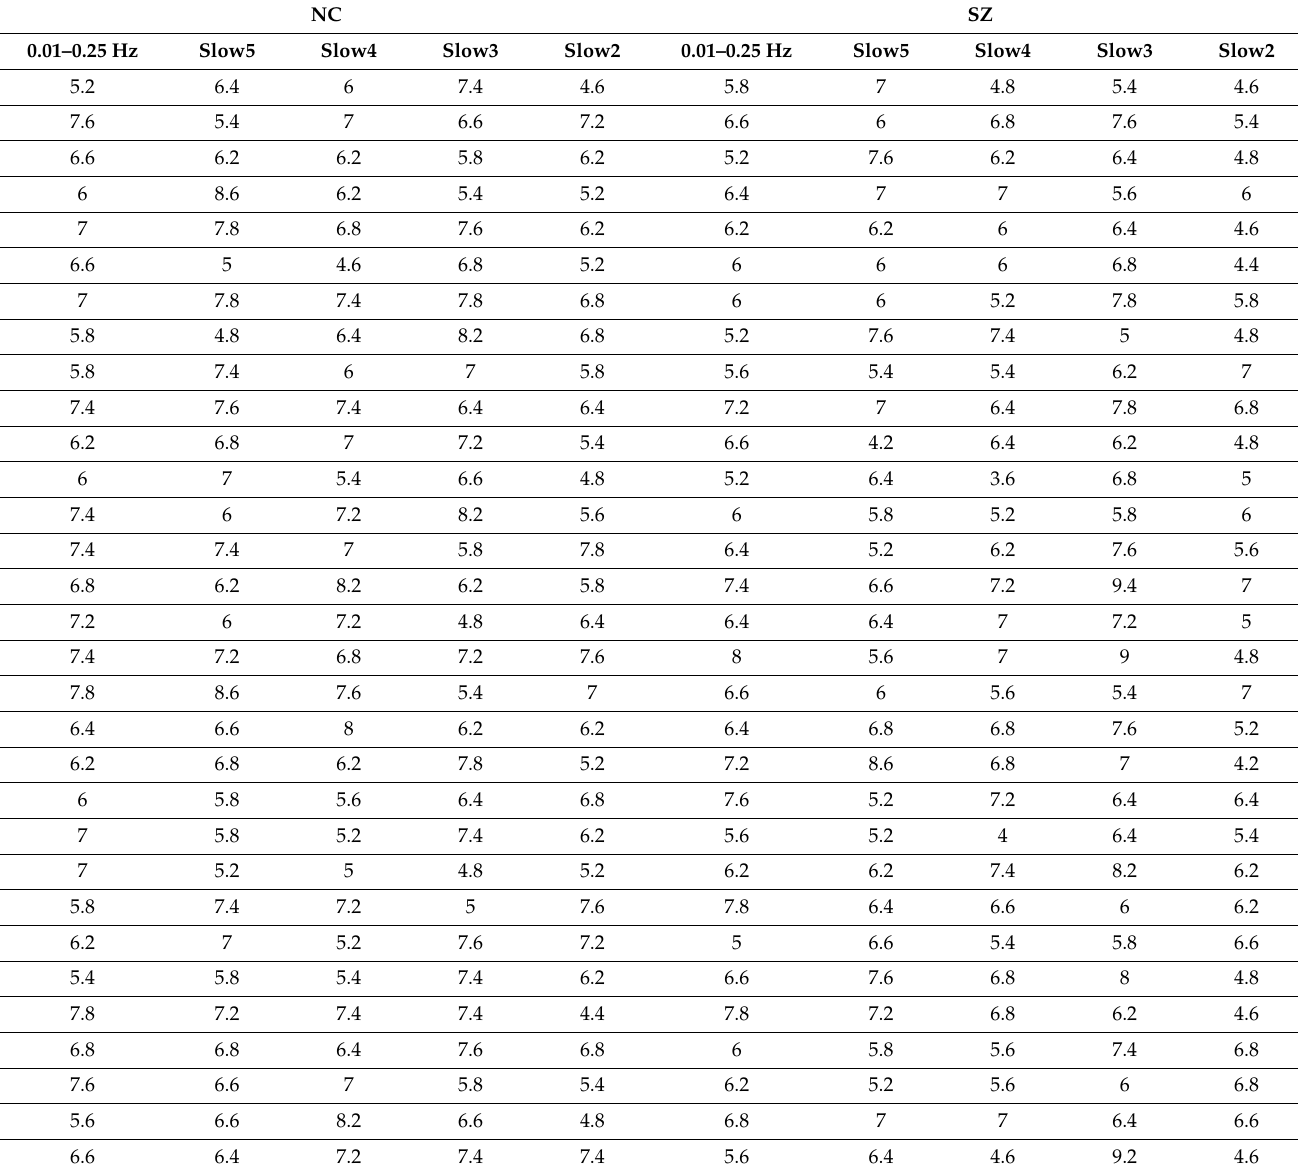
Table 2. The number of modules in full frequency (0.01–0.25 Hz), slow5 (0.01–0.027 Hz),